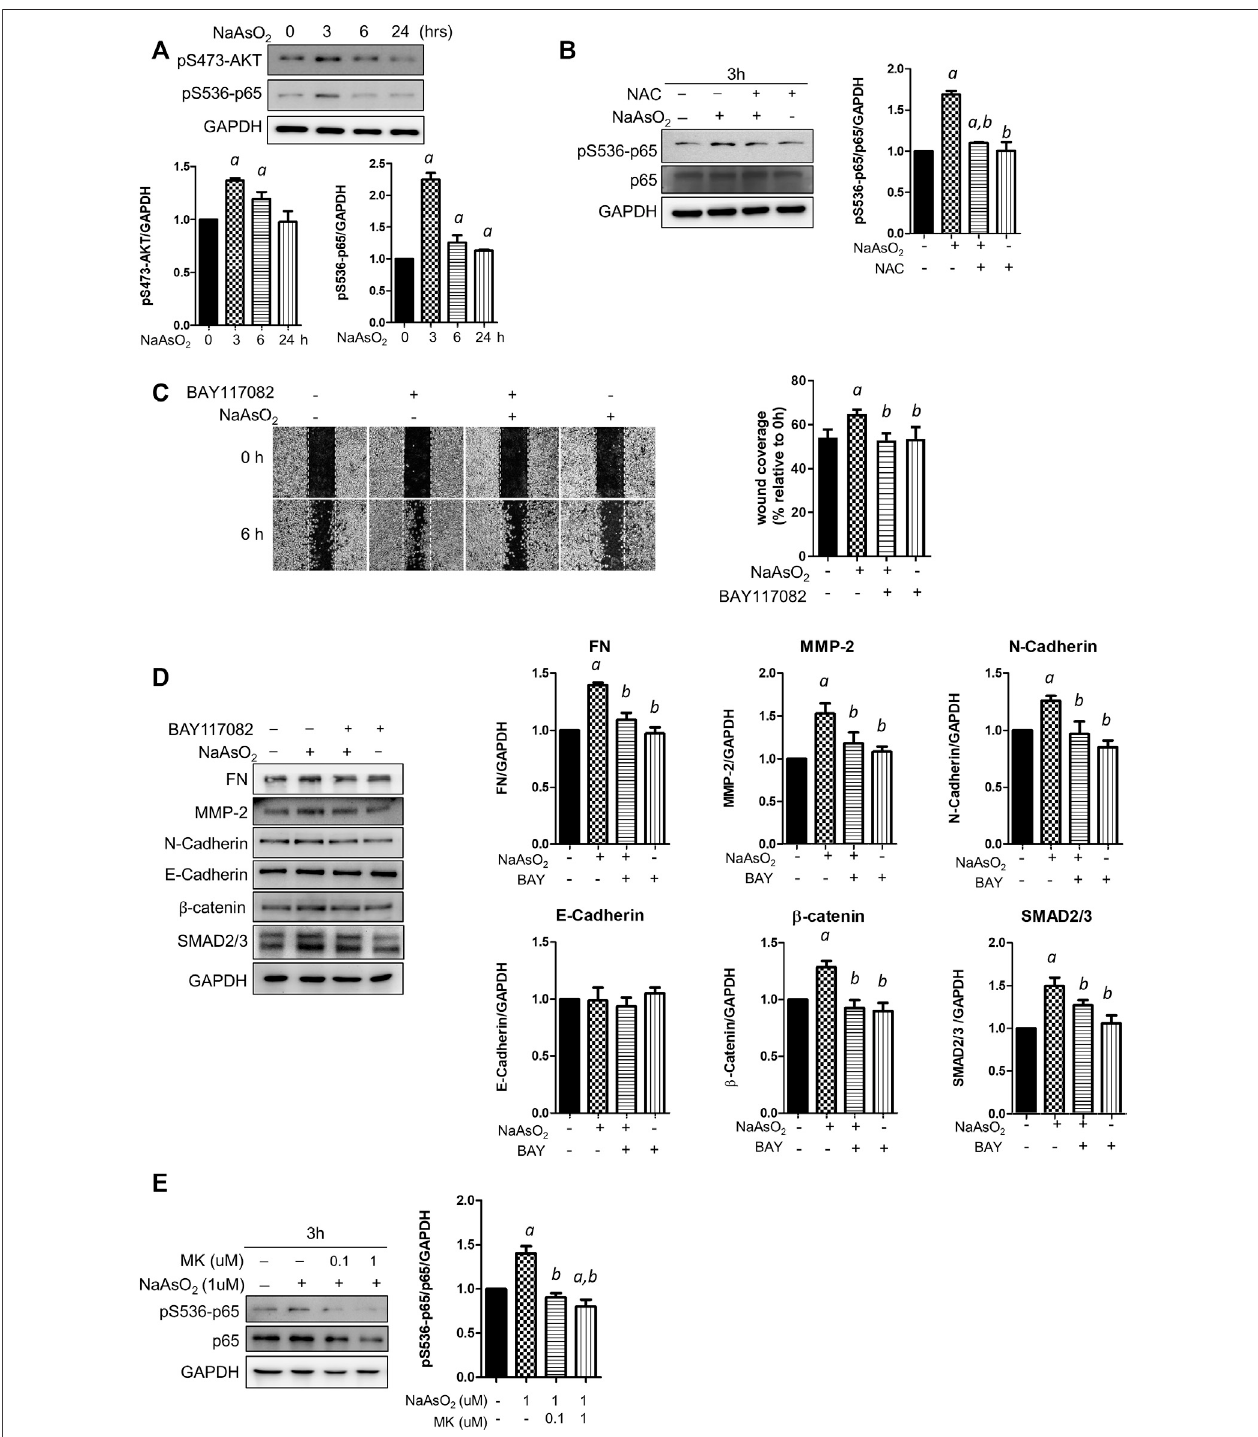
FIGURE4| TheeffectsofmontelukastonNF- κ BactivationandoftheinhibitionofNF- κ Bonmediatedarsenic-inducedEMTofNHBEcells. (A) Arsenicinducedthe phosphorylation of AKT and p65. Cells were treated with 1 µM NaAsO 2 for different time intervals, and the cells were harvested and subjected to western blot analysis usingaphospho-antibody. (B) NACtreatmentinhibitedarsenic-inducedphospho-p65.CellswerepretreatedwithNACfor2 h,andthenNaAsO 2 wasaddedforanother 3 h. The expression of phospho-p65 was determined with a phospho-Ser536-p65 antibody. GAPDH served as the internal control. (C) Treatment with an NF- κ B inhibitorreducedarsenic-inducedcellmigration.Cellswerepretreatedwith2 µMBAY117082for2 handthentreatedwith1 µMNaAsO 2 foranother24 h.Awoundwas madewitha200-µltip,andthewoundcoveragewasanalyzedbycomparingthecell-occupiedareaat0 hversusthat6 hafterthewoundwasmade.Therepresentative